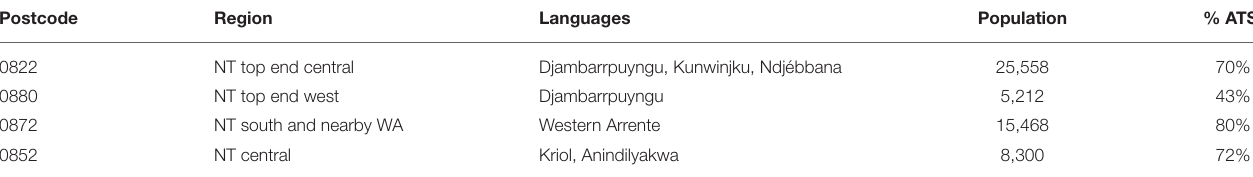
TABLE 1 | Postcodes and populations.